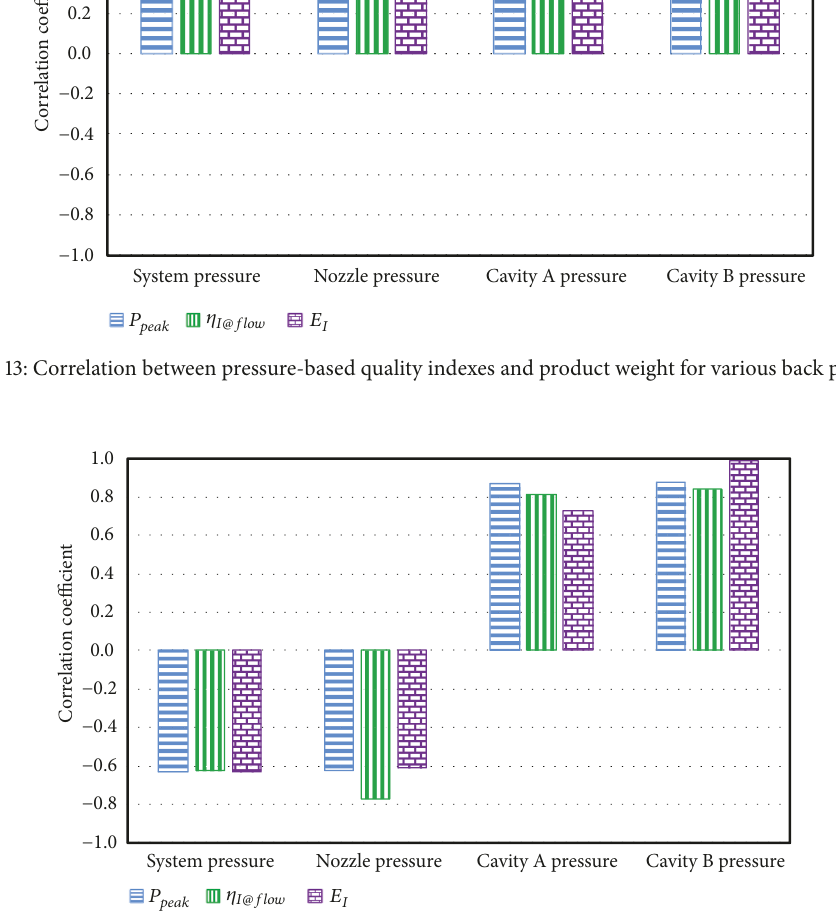
Figure 14: Correlation between pressure-based quality indexes and product weight for various screw rotational